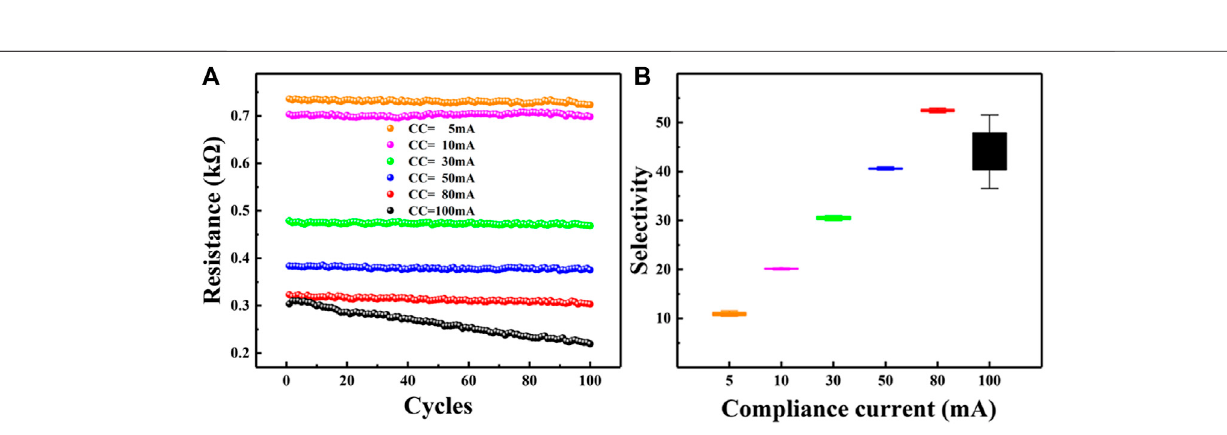
Frontiers in Materials |